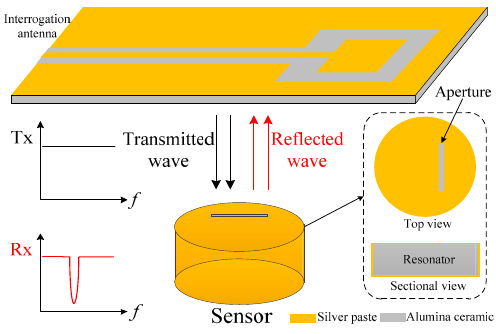
Figure 1. Schematic of the temperature sensor signal transmission mechanism.